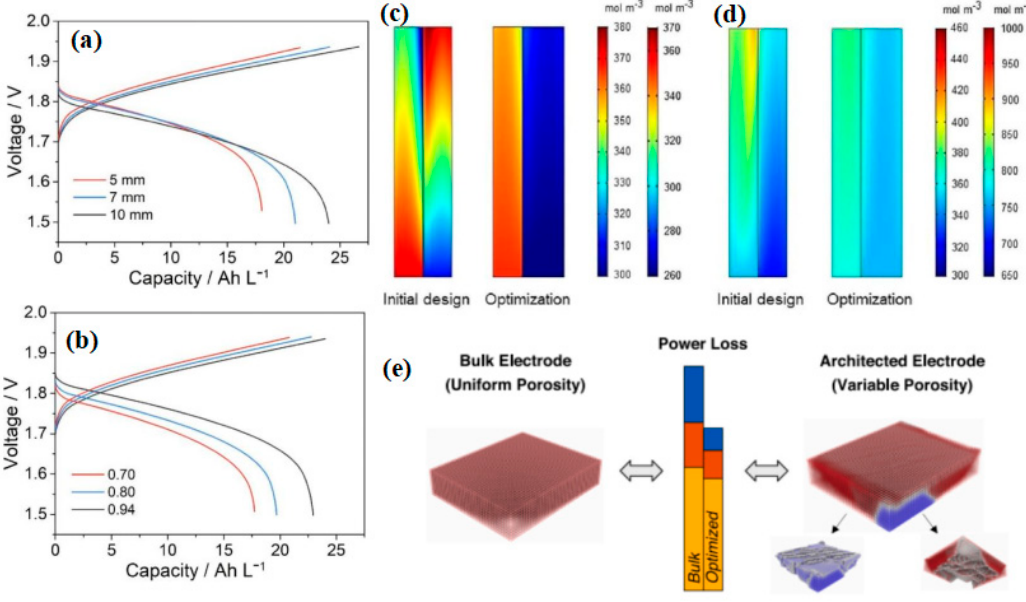
Figure 6. Charge–discharge voltage profiles with different electrode porosity ( a ) and electrode thicknesses ( b ); comparison of performance between the various designs: the species distribution at a 50 percent stage of Zn(OH) 42 − (left side) and Fe(CN) 63 − (right side) during charge ( c ), and Zn(OH) 42 − (left side) and Fe(CN) 64 − (right side) during discharge ( d ). Reproduced with permission from [88]. Copyright 2021, Elsevier. ( e ) The total power loss including hydraulic losses (blue), electric transport losses (red), and internal electric losses (yellow) for the bulk electrode (left) and the optimized electrode (right). Reproduced with permission from [89]. Copyright 2021, Elsevier.